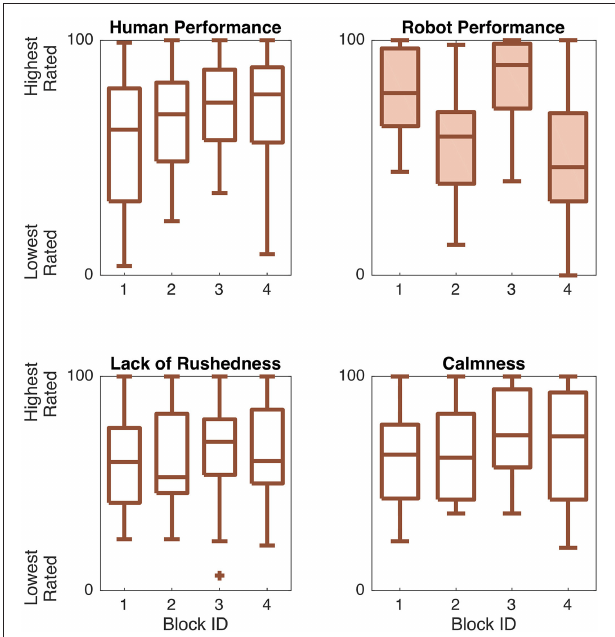
FIGURE 10 | Differences in responses to TLX-related survey questions over interaction block. Shaded boxes are significantly different from at least one other condition.